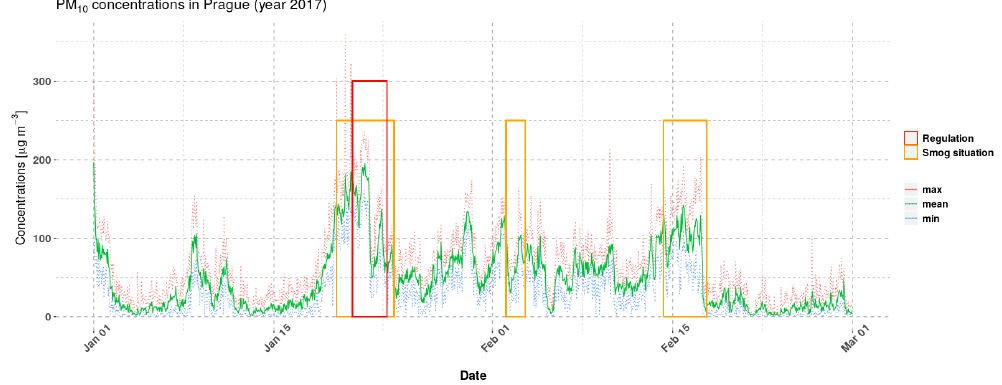
Figure 4. Minimum, mean, and maximum hourly PM 10 concentrations from eight background stations in Prague with the indication of the announced smog situations and